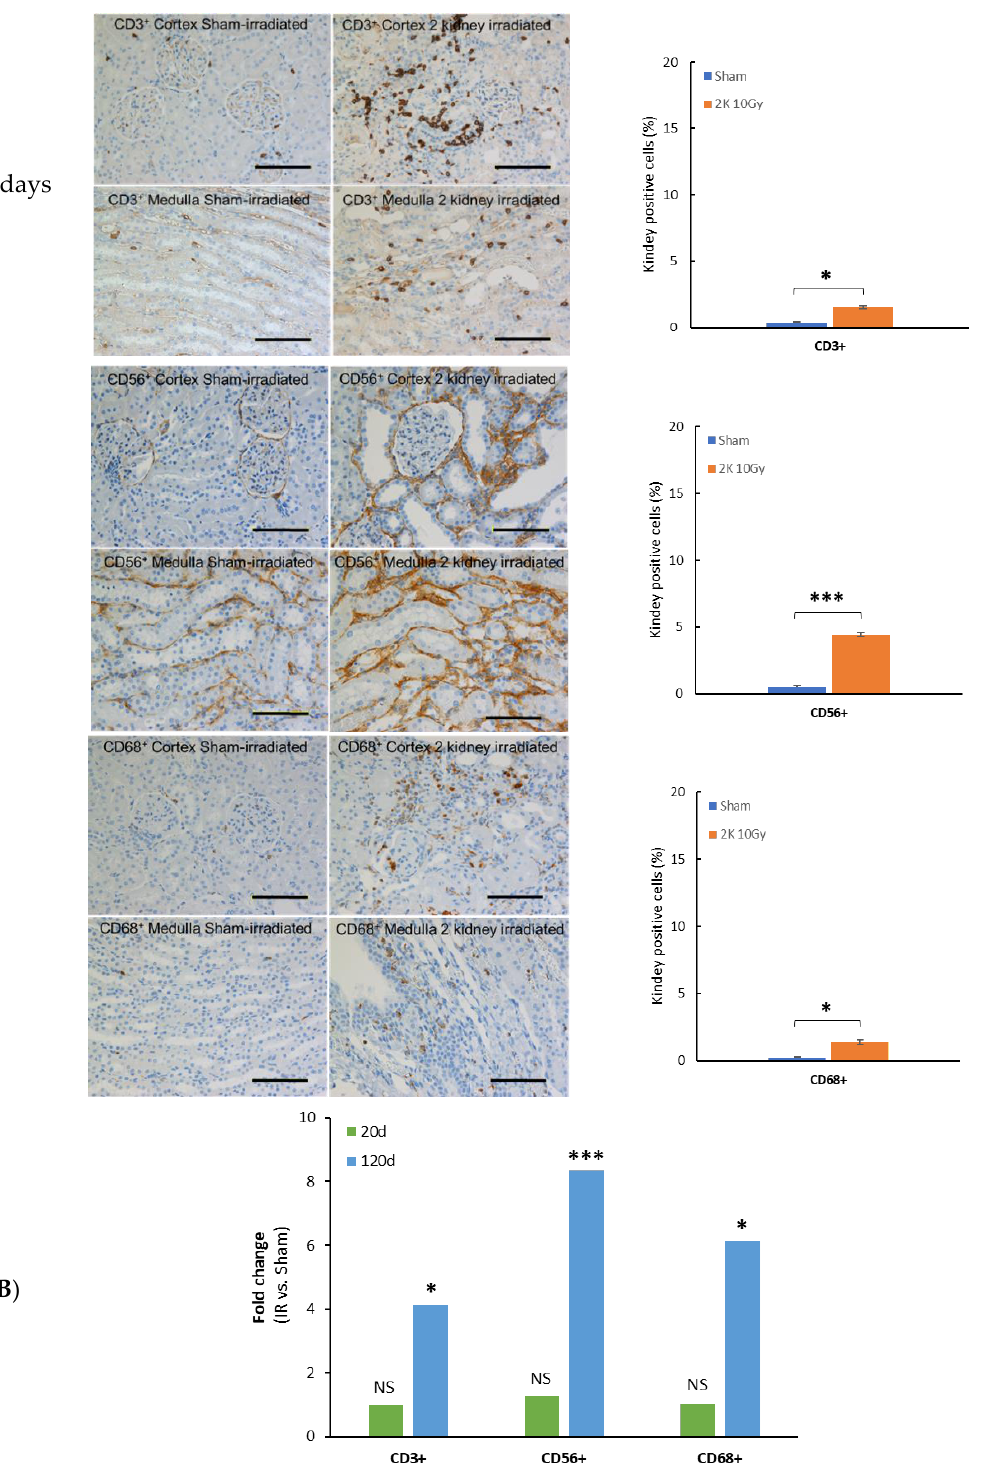
Figure 2. Immune cell infiltration of the cortex and medulla of kidney after local X-irradiation with 10 Gy in wild-type rat. ( A ) T cells (CD3 + ), natural killer cells (CD56 + ) and macrophages (CD68 + ) appear as brown color. The horizontal scale bar represents 100 microns. Images are representative data from 3–4 animals per group. Quantification of immune cells in cortex and medulla of kidney. ( B ) Comparison of changes between 20 days and 120 days. Data are mean + SEM. * = p < 0.05 vs. sham-irradiated control. *** = p < 0.001 vs. sham-irradiated control.